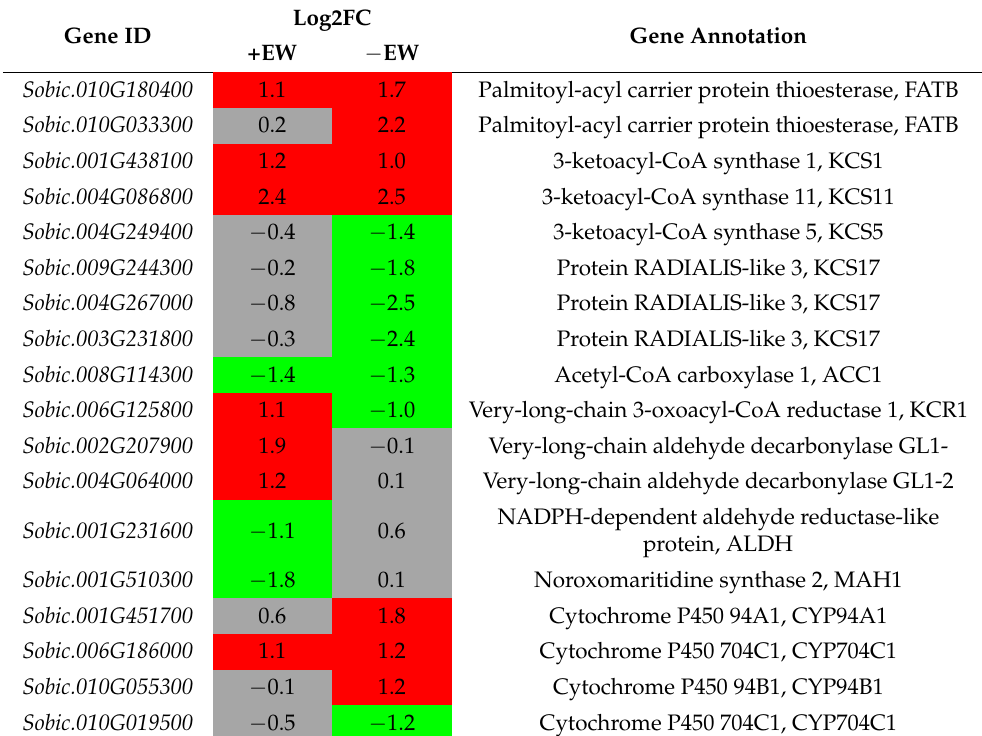
Table 1. Fatty-acid-synthesis-related genes regulated upon infection in sorghum at 3 days post inoculation: +EW indicates plants with epicuticular wax and − EW indicates the plants without EW. FC means Fold Change of gene expression level between treatment and its control. The red color rep- resents Log 2 FC > 1, green color represents Log 2 FC < − 1, and gray color represents − 1 ≤ Log 2 FC ≤ 1. Log2FC Gene ID −